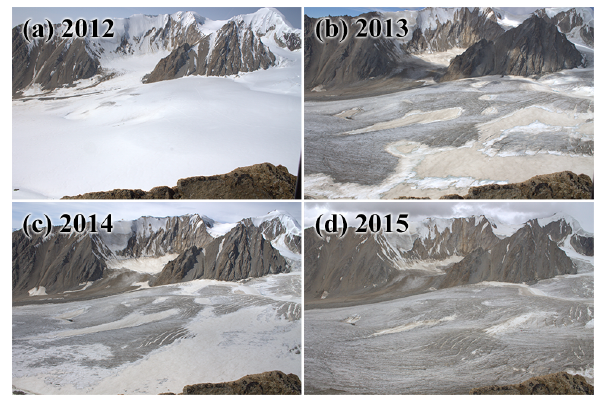
Figure 3. Photographs of the study area taken from camera C1 (see Fig. 1) on 19 July 2012–2015, as indicated in each panel. The inter- annual variability evident in the photo will be discussed in Sect.